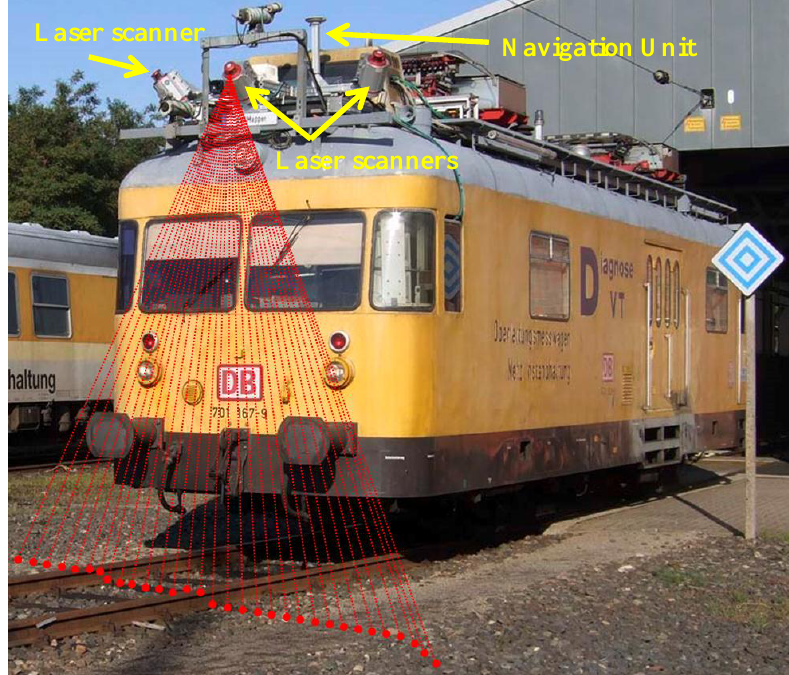
Figure 1. A sample mobile mapping system mounted on a train with three laser scanners